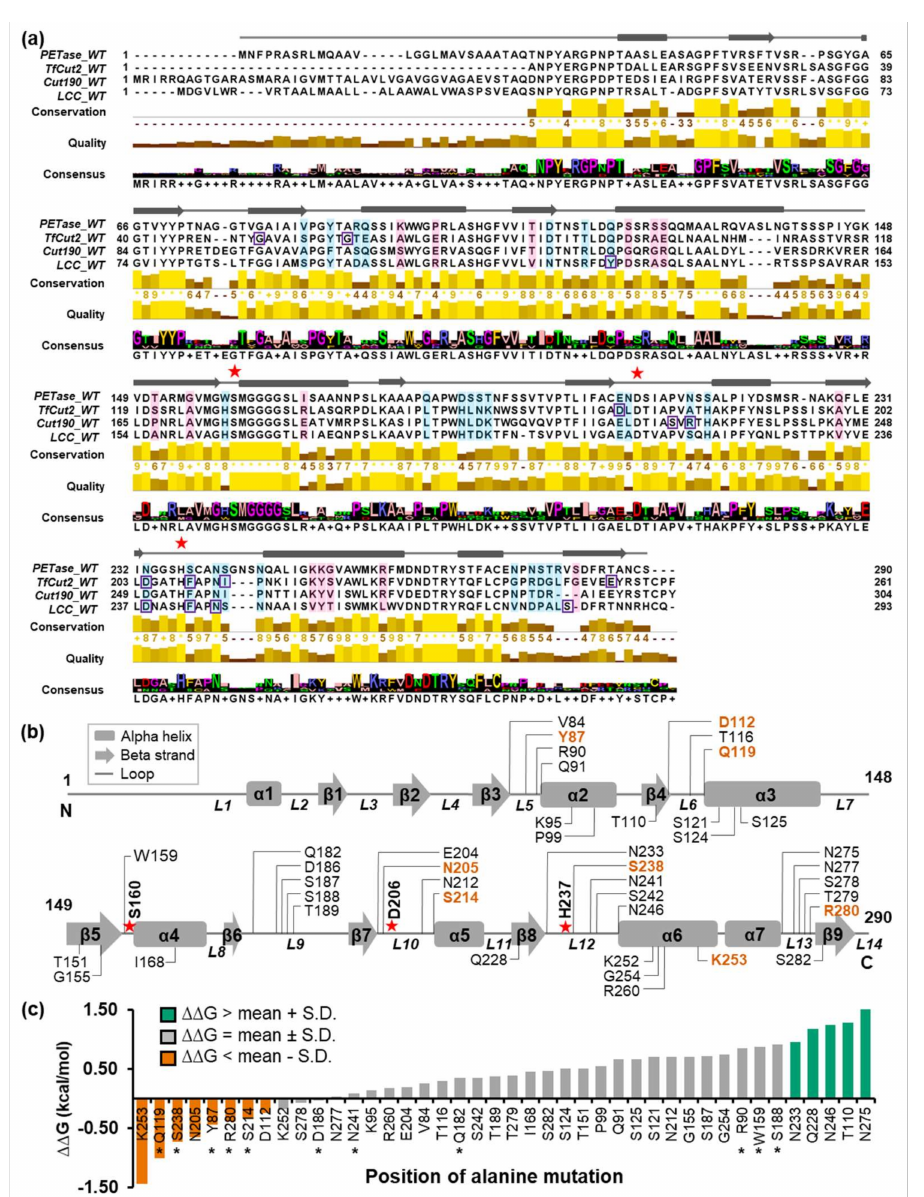
Figure 1. MSA of PET-degrading enzymes and the free binding energy of the PETase-PET complex. ( a ) Amino acid sequences of four PET-degrading enzymes were aligned. The PETase secondary structure elements were indicated in the top panel with a gray rectangle and arrow for α -helix and β -sheet, respectively. Amino acid sequences with low conservation scores were highlighted with blue and pink boxes for the loop and the non-loop region residues. Reported amino acid sites for mutagenesis were in purple boxes. The conservation, quality, and consensus were illustrated at the bottom. ( b ) The positions of 42 selected amino-acid residues of PETase were indicated in the secondary structure. ( c ) The bar graph showed the relation between the ∆∆ G of each PETase variant-PET complex and the position of alanine mutation. The conformation of the PET substrate (2-HE(MHET) 4 ) binding to PETase was selected to determine ∆ G, which was then compared with that of the WT PETase, ∆∆ G. The asterisks specify the validated residue in the previous studies, Figure S7. ( a , b ) The S–D–H catalytic triad was marked as red five-pointed stars. ( b , c ) The eight selected amino acid residues were highlighted in